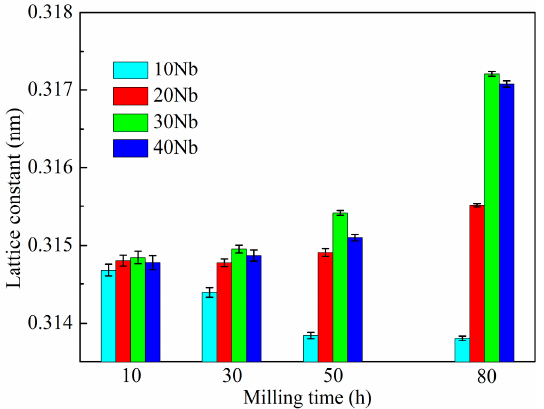
Figure 4. Evolutions of ( a ) domain size and ( b ) microstrain of Moss as a function of milling time for 10Nb, 20Nb, 30Nb, and 40Nb powders. The vertical lines are error bars.